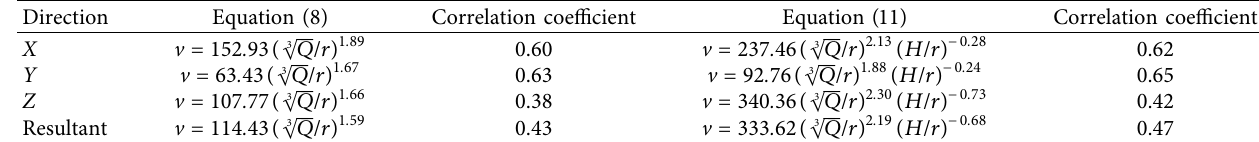
Table 9: Prediction model of attenuation laws of blasting vibration